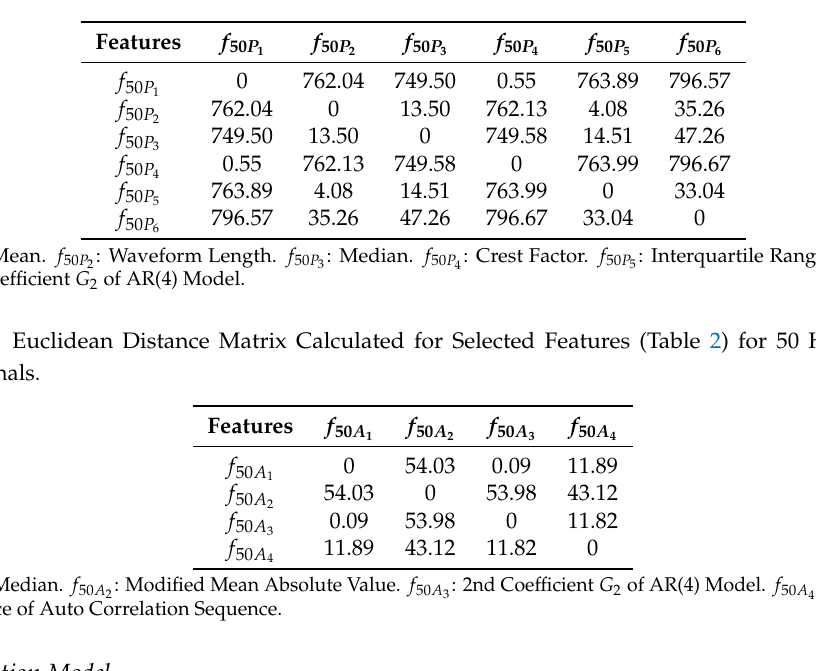
Algorithm 1 Training Algorithm of the SVM